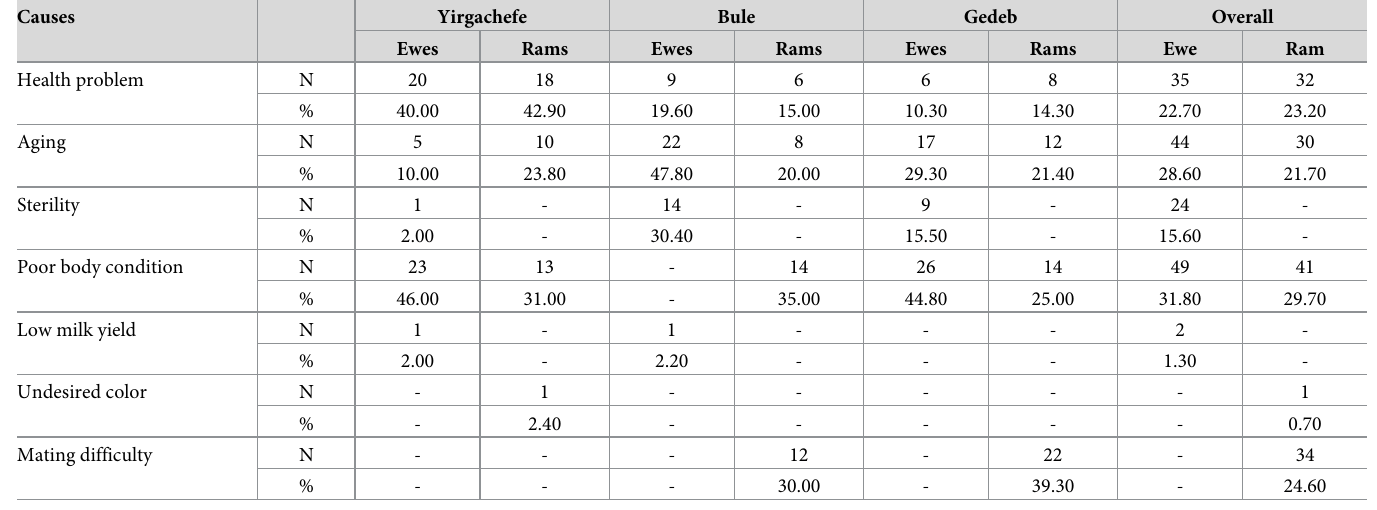
Table 11. Causes for sheep